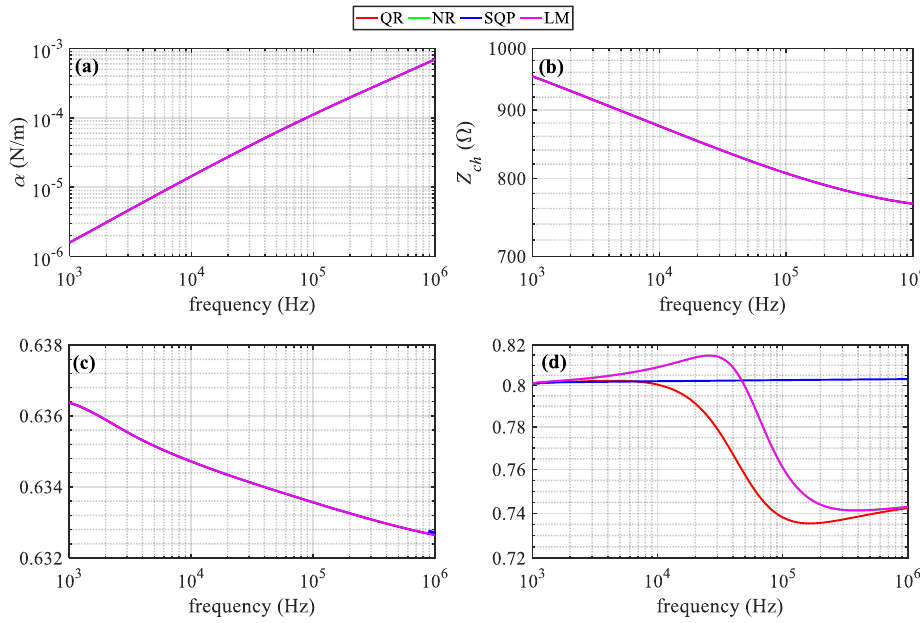
Figure 22. Ground mode ( a ) attenuation constant, ( b ) characteristic impedance magnitude and magnitude of the ( c ) element (1,1) and ( d ) element (1,2) of the transformation matrix for different methods. NB range.